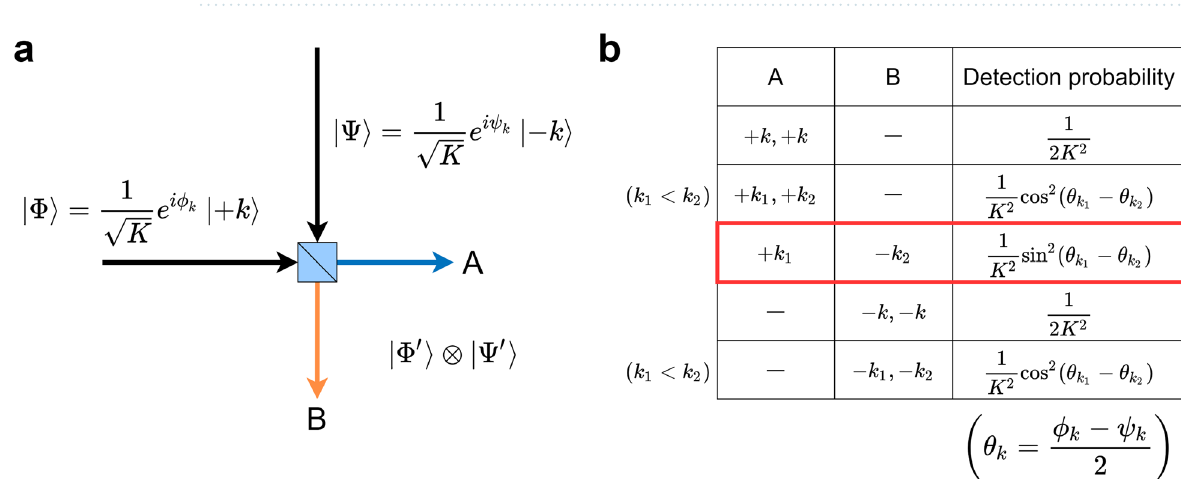
, (cid:31) (cid:30) go into BS as two inputs and go out to A and B. (b) Probability | � | �